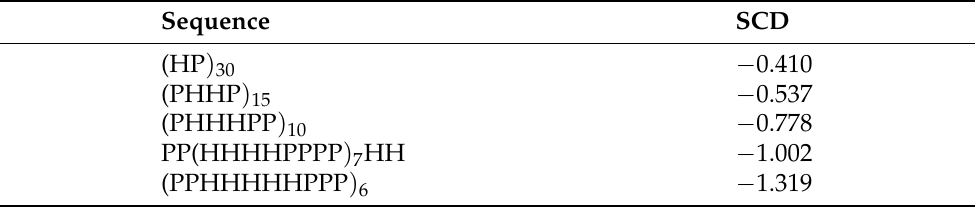
Table 1. Sequences composed of 30 cohesive monomers (“H”) and 30 neutral monomers (“P”) of different sizes (1, 2, 3, 4 or 5) of cohesive (and neutral) clusters. The subscripts indicate how many times the sequence in parentheses is